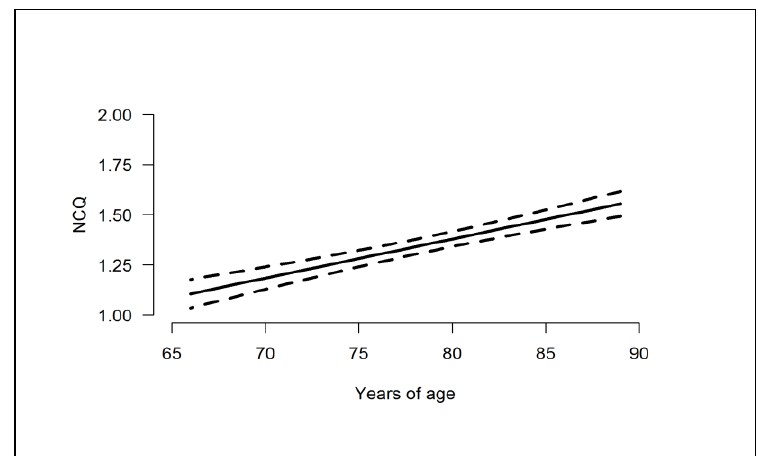
Figure 1. Estimated effect of age and its 95% confidence interval on NCQ score.